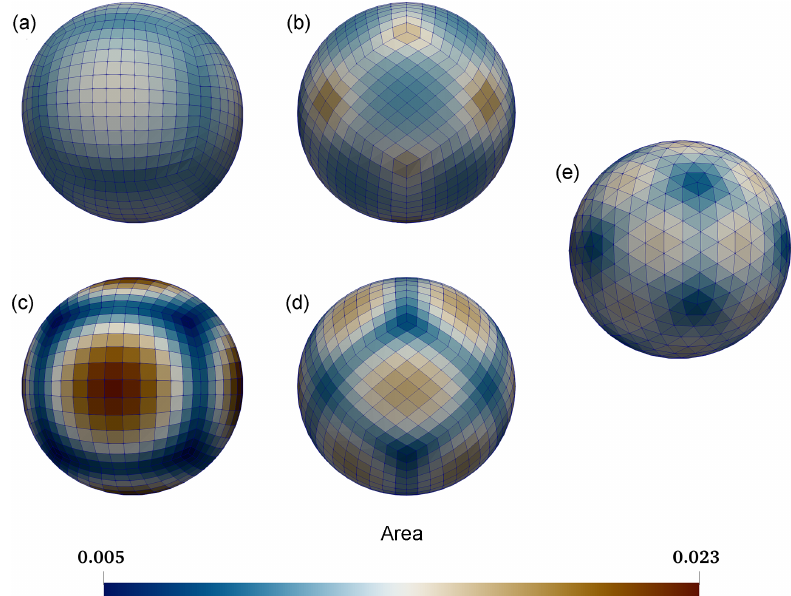
Figure 6. Elemental area for the (a) equiangular HS06 mesh, (b) equiangular HS12 mesh, (c) equidistant HS06 mesh, (d) equidistant HS12mesh and (e) HS20 (level